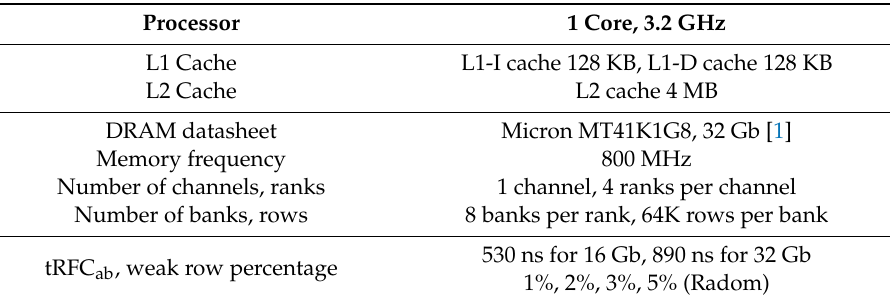
Table 3. System configurations.